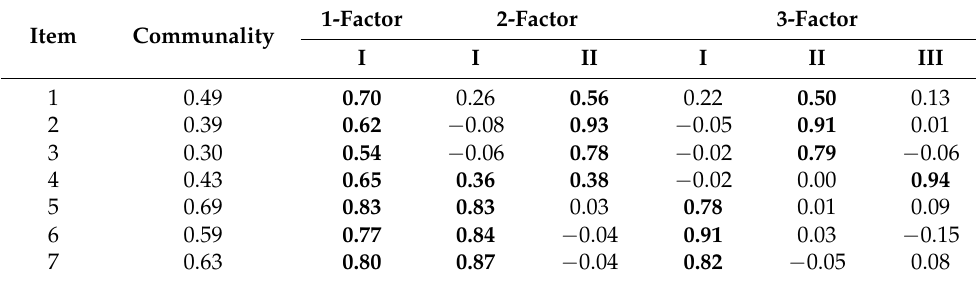
Table 2. The EFA of the ISI ( n